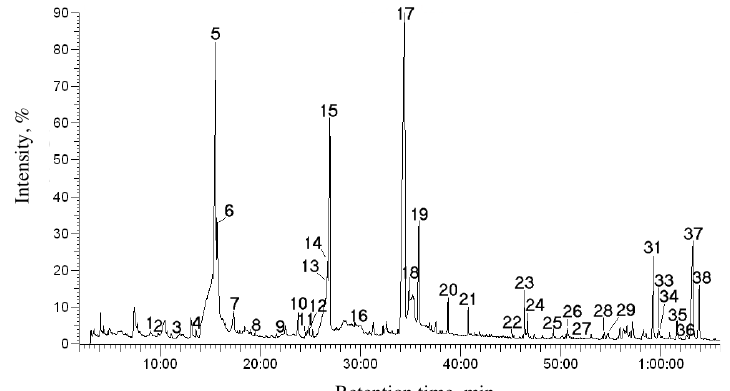
Figure 1. GC-MS chromatogram of aromatic compounds in manuka honey ( A ), Peak